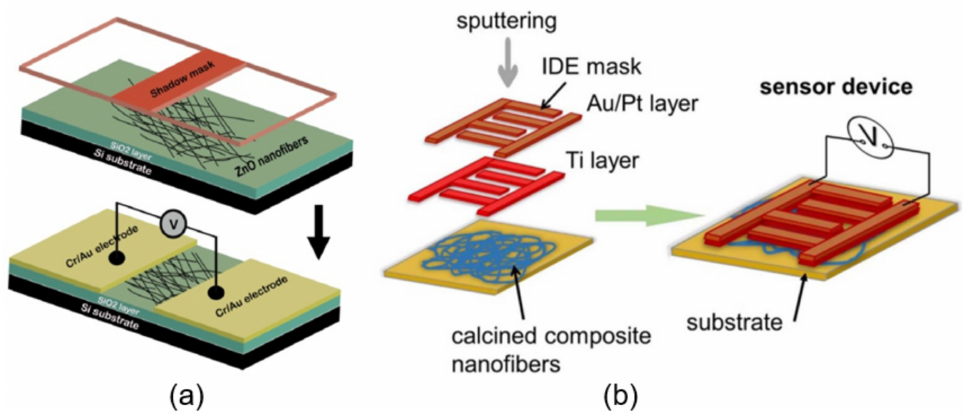
Figure 2. ( a , b ) Schematic illustrations of the fabrication process of metal oxide nanofiber-based sensor with ( a ) Au and ( b ) Ti-Au/Pt electrodes deposited on the nanofibers. ( a ) Reprinted from [78].; ( b ) Reprinted with permission from [79]. Copyright 2015